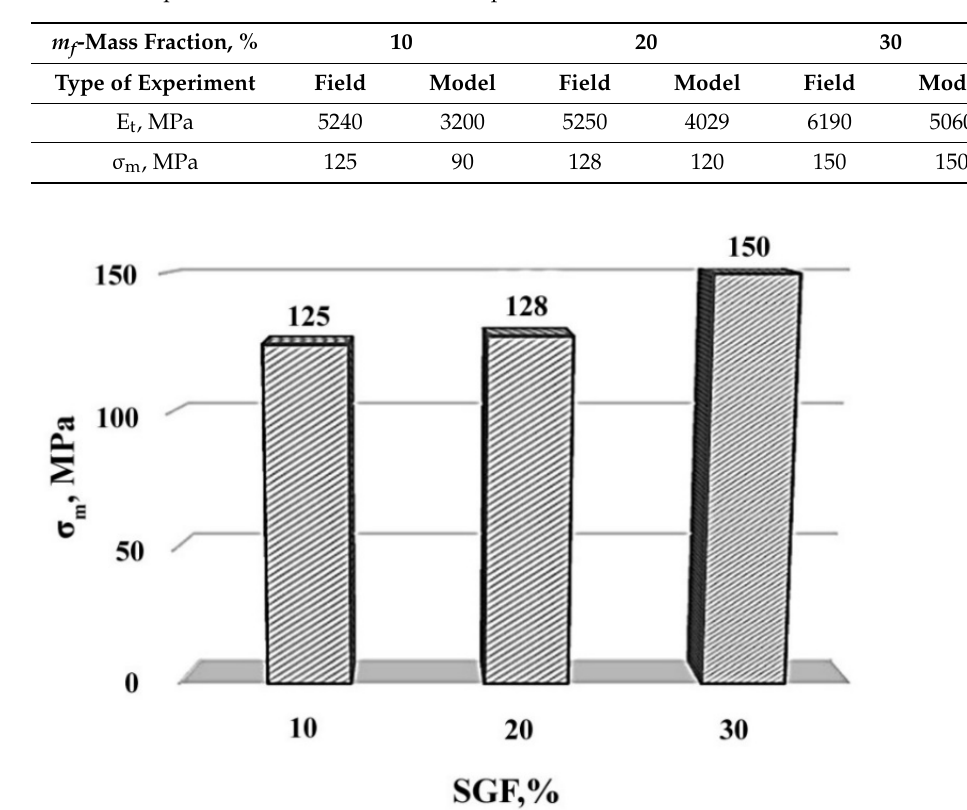
Figure 8. Change in the tensile strength ( σ m, MPa) of polycarbonate composites filled with different amounts of SGF (%). Table 4. Comparison of numerical and field experiment results.